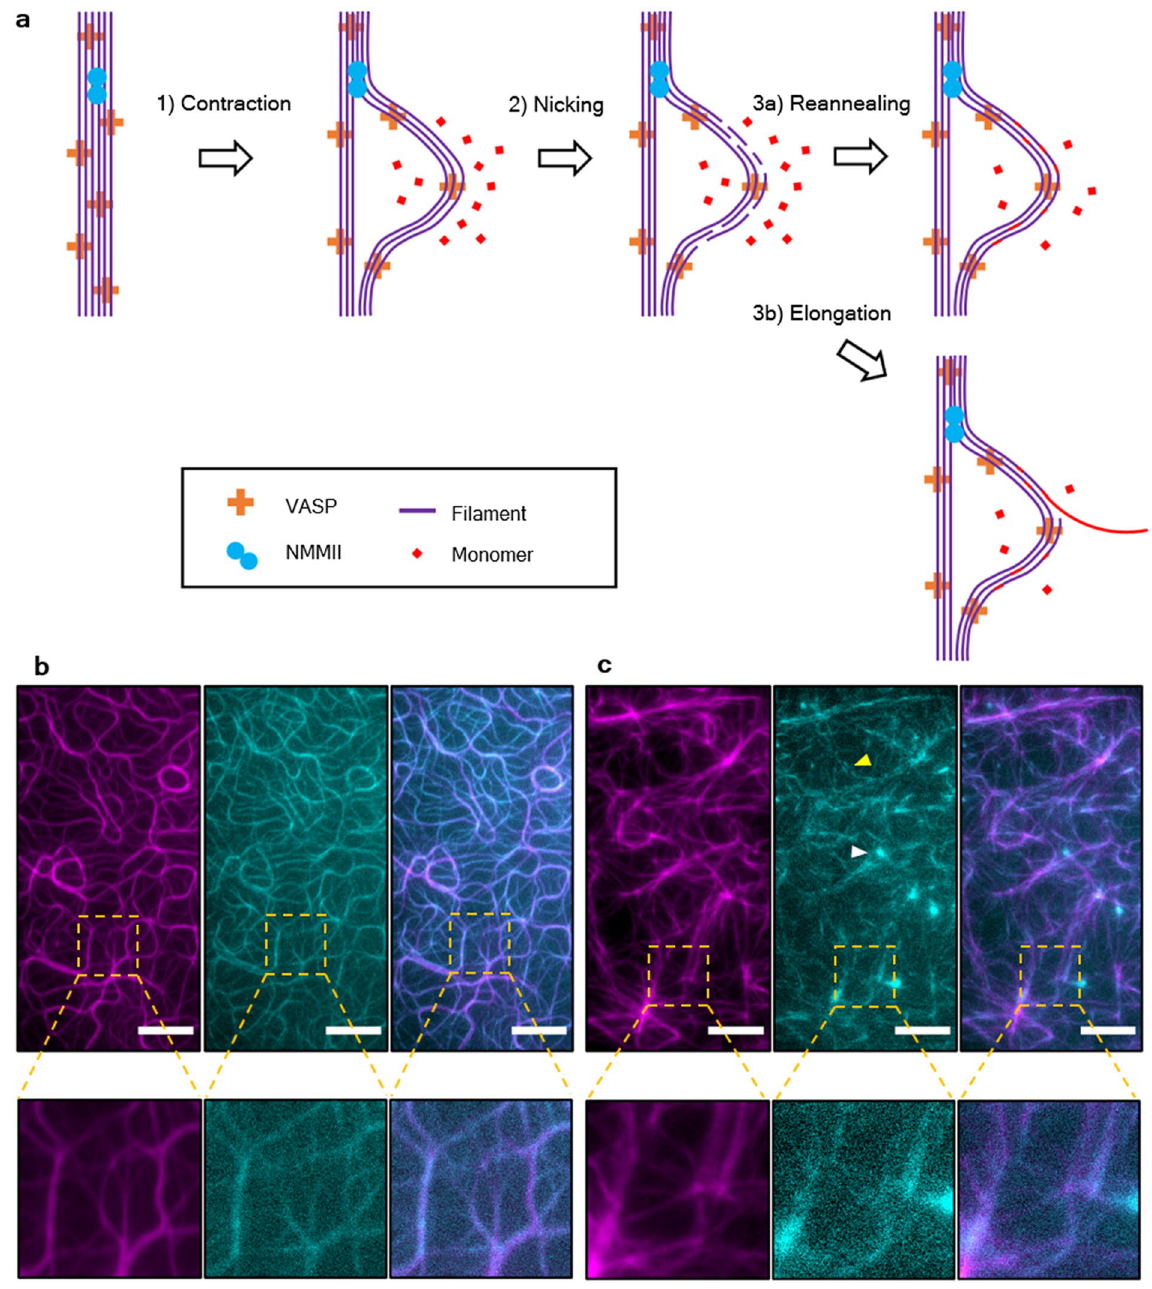
Figure 5. Network growth mechanism by cluster expansion. ( a) Mechanism explaining the altered growth mechanism in networks containing NMMII. Due to the transient crosslinking by the lipid anchored VASP (orange crosses), individual filaments (magenta lines) can be pulled along each other by NMMII (cyan circles), resulting in intra-bundle contractions. Stress built up by the contraction can lead to severing of individual filaments, which either creates barbed ends that can elongate away from the complex, or reannealing of the ends while incorporating free monomers (red dots). The latter mechanism explains the cluster swelling growth that has been observed in these networks. ( b) First, actin containing a 10% fraction of Atto 488-labeled monomers (magenta) was pre-polymerized for 20 min on a VASP functionalized supported lipid bilayer (left image). Then, an additional 10% fraction of Atto 647N-labeled monomers (cyan) was added to the polymerization mixture and allowed to be incorporated for 10 more minutes (middle image). The right image depicts an overlay of both channels. The filament elongation could be observed along the previously formed bundles. ( c) Actin containing 488-labeled actin was pre-polymerized as before but with NMMII in solution (left). The second color (middle) is incorporated at previously formed clusters and alongside previously formed bundles, however much less uniformly compared to the network without NMMII. This leads to individual spots and dashed lines appearing in the second color indicating that monomers are incorporated preferentially on filament-barbed ends created by rupturing within the network due to intra-bundled stresses. An example of this type of incorporation is shown by a yellow arrow. Additionally, new clusters formed in regions where no clusters have been pre-polymerized. An example for one of those clusters is marked with a white arrow. This is visualized best in an overlay of both images (right). Scale bars = 10